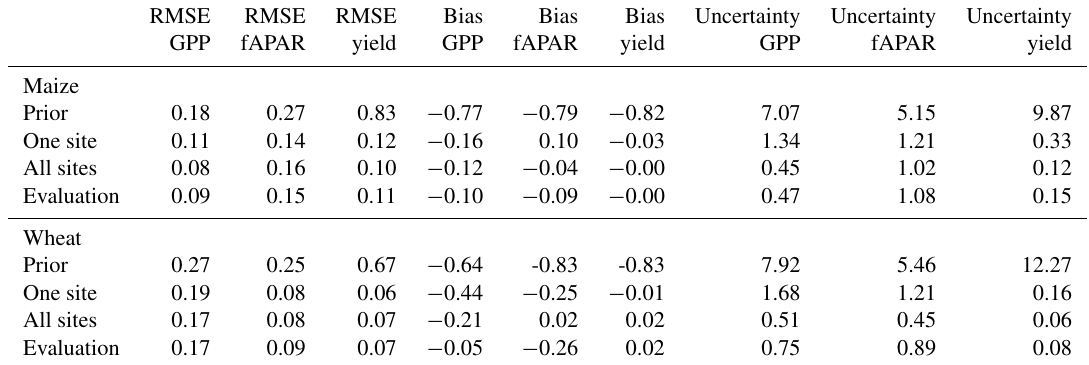
Table 3. Model RMSE, bias and uncertainty for the one-site and all-site parametrisation as well as the model evaluation run.